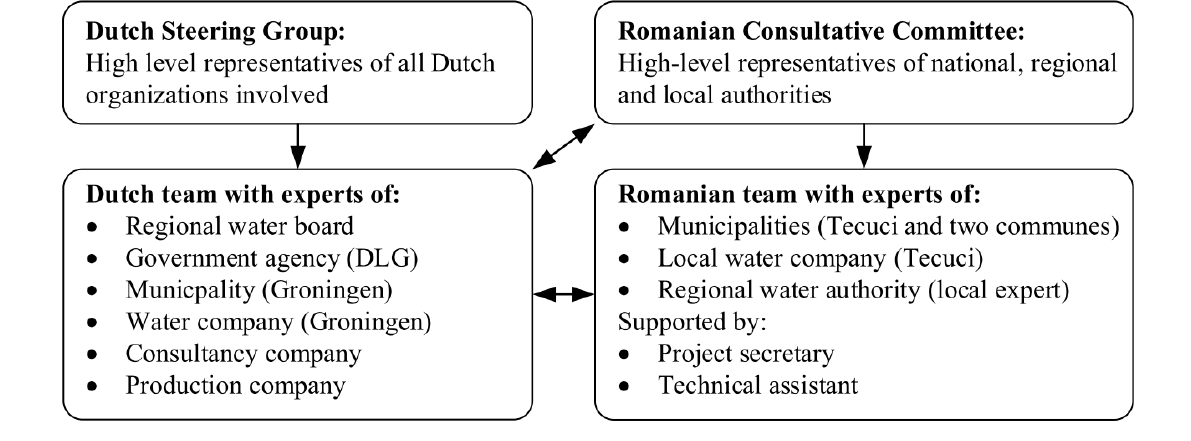
Fig. 2 . Project structure: a Dutch steering group and team and a Romanian consultative committee and